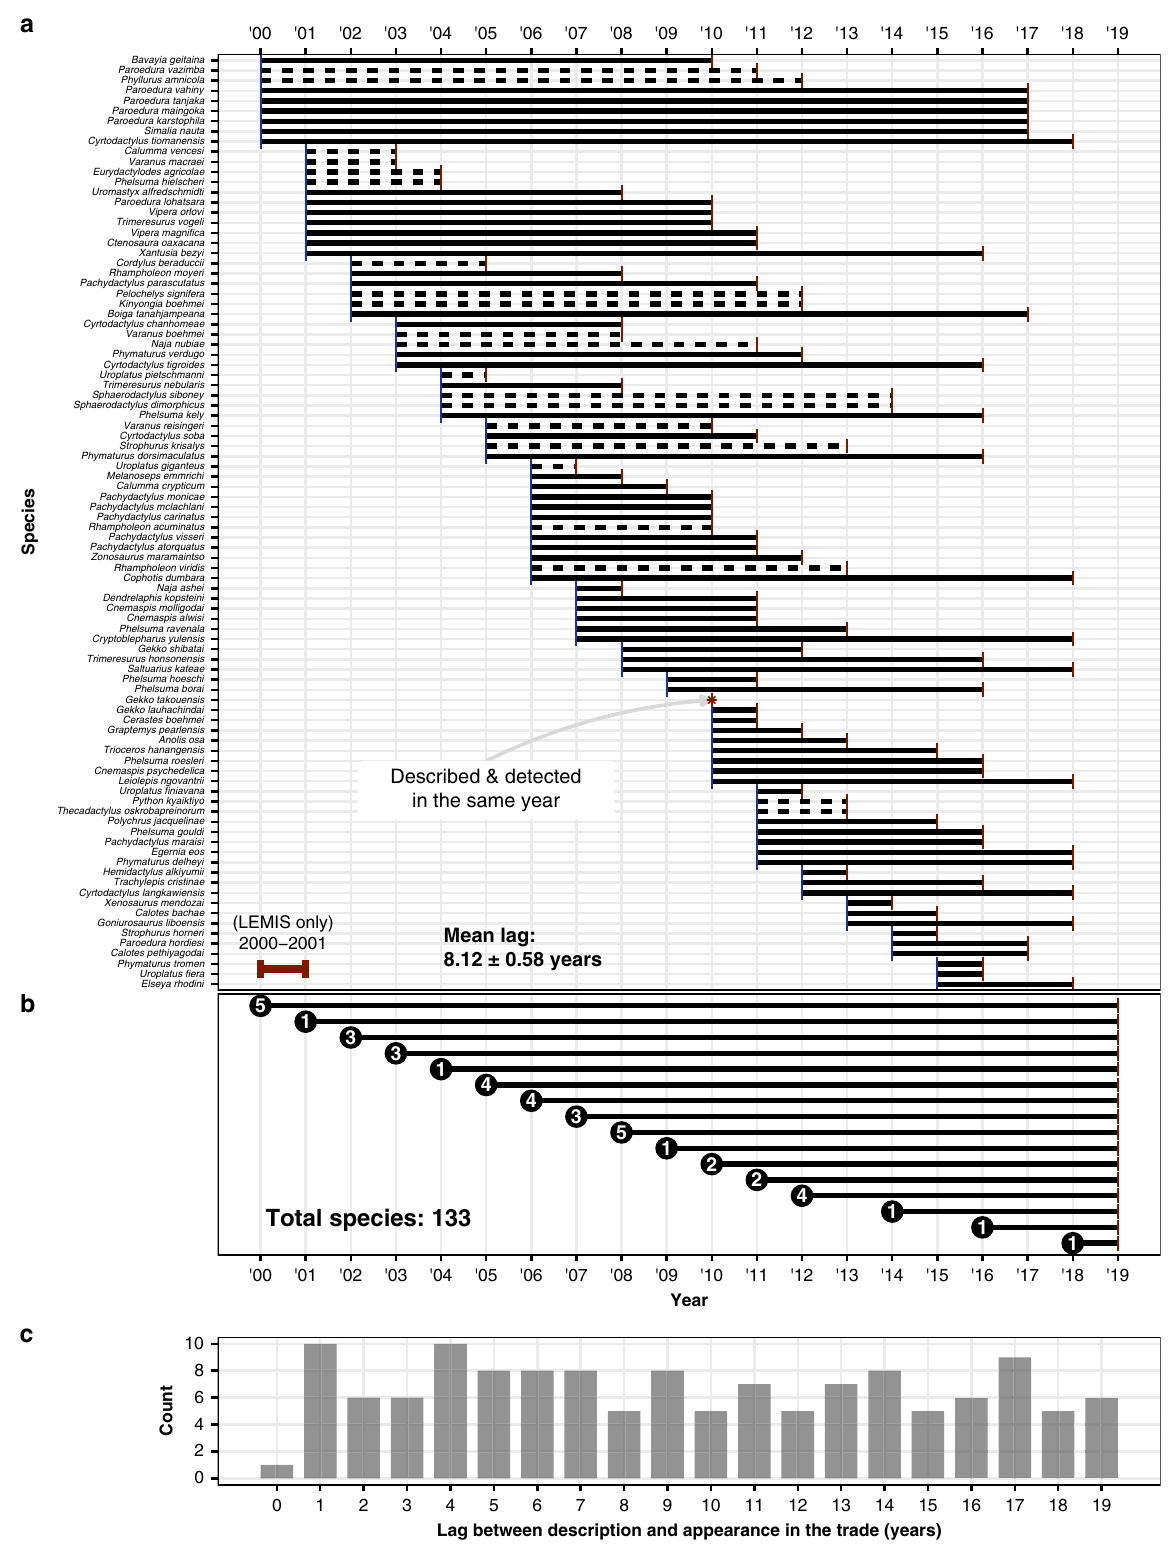
Fig. 4 Time lag between post-1999 species descriptions and their appearance in the online trade or in the LEMIS database. a Species detected during the temporal online sampling from the most species-rich website (solid lines), or in the LEMIS data (dashed lines) that allowed for an earliest-year- detected. The period 2000 – 2001 is only covered by LEMIS data. LEMIS data shown here excludes non-commercially traded species. b Counts of species described after 1999 but only detected in the 2019 snapshot data: the actual appearance date in the trade is likely before 2019. c Frequency plot of species lag